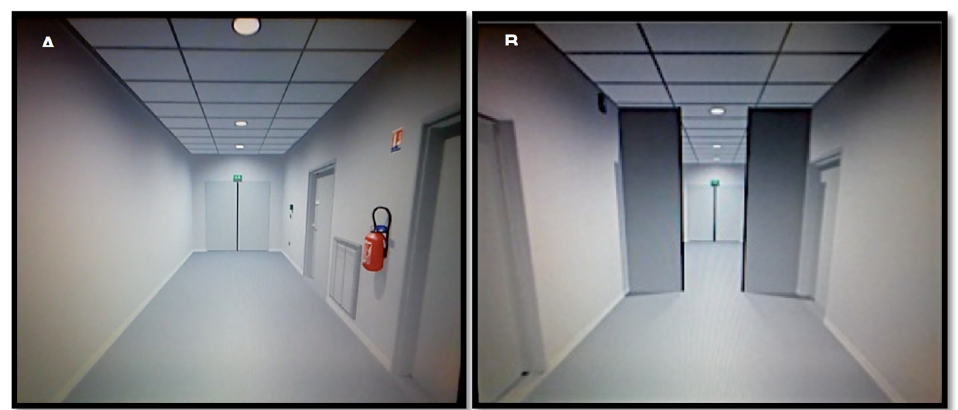
Fig 1. Screen captures of the virtual gait task. The task comprised pendular movements from a first person perspective to enhance imaginary gait during the fMRI session of gait without (A) and with (B) a doorway.